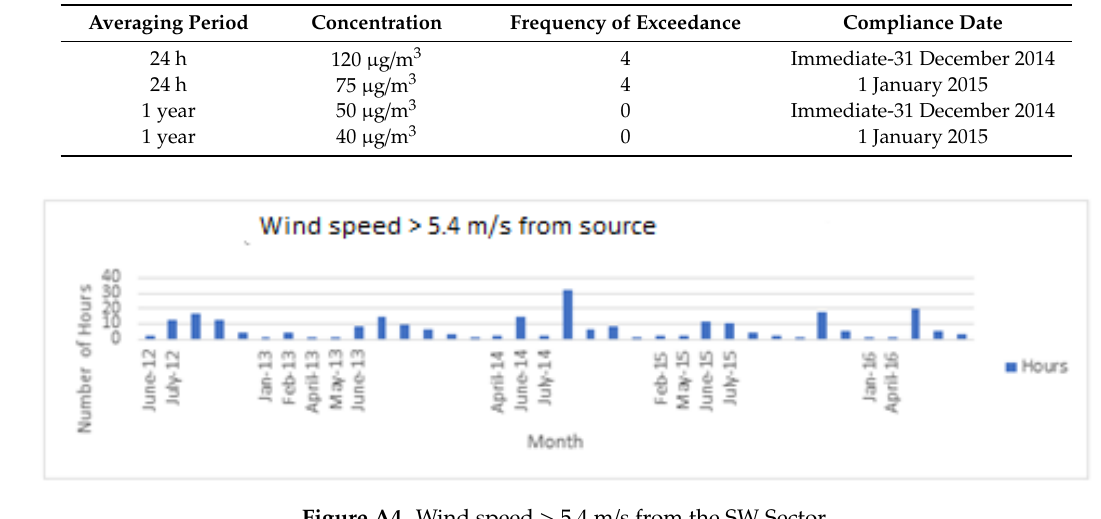
Table A3. National Ambient Air Quality Standard for Particulate Matter (PM 10 ). Figure A3. Distance covered by dust in the mine village.